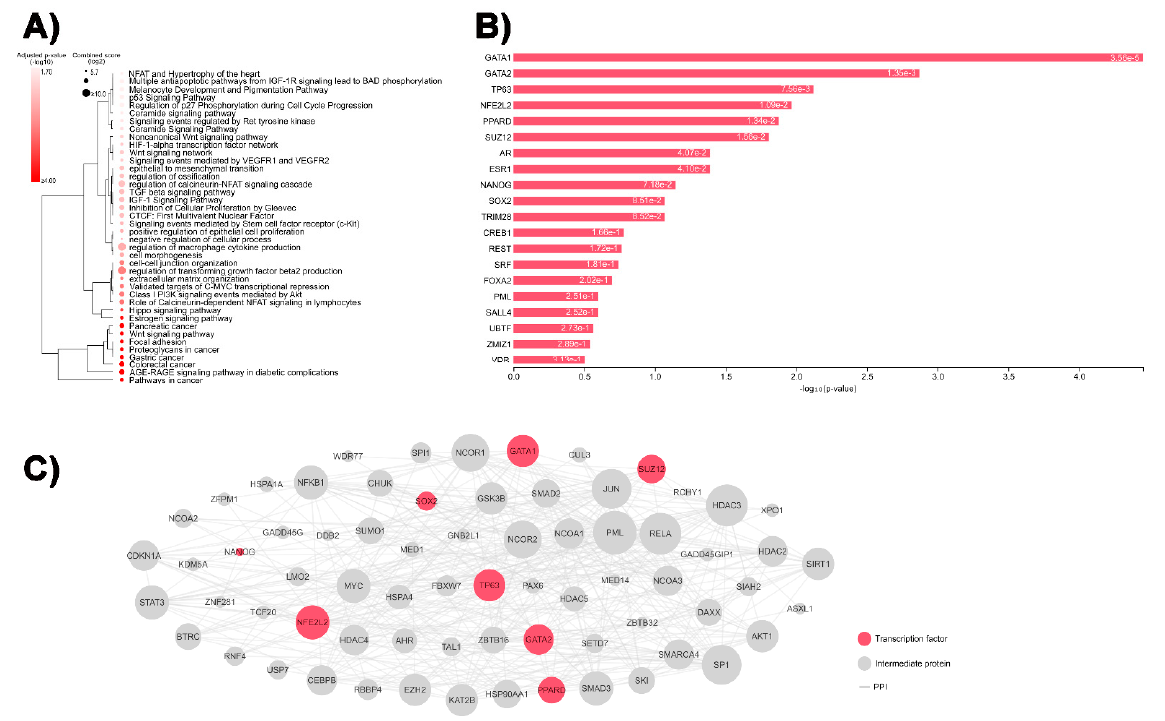
Figure 2. Enriched downstream pathways and upstream transcription factors (TFs) identified by in silico analyses: ( A ) bubble heatmap representing enriched gene ontologies and pathways for the 104 differentially expressed genes (DEGs) from Figure 1; ( B ) top 20 enriched TFs putatively involved in the regulation of the DEGs; ( C ) upstream regulatory network of the DEGs showing protein–protein interactions (PPIs) between the top-ranked TFs and their intermediate proteins. The size of the nodes is proportional to their degree.